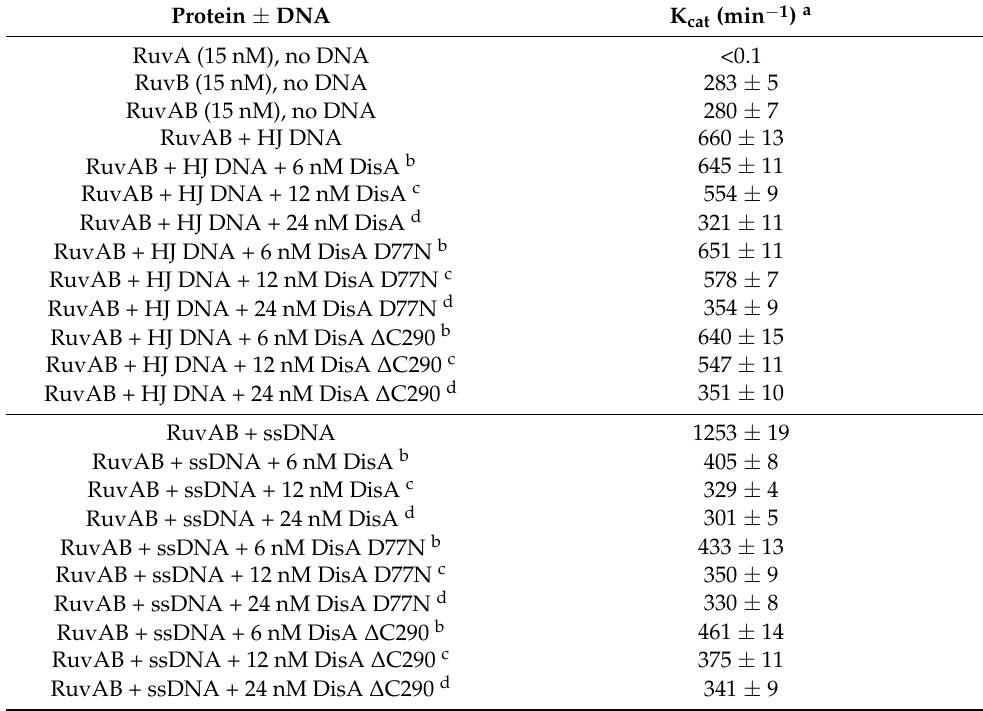
Table 1. RuvAB rates of ATP